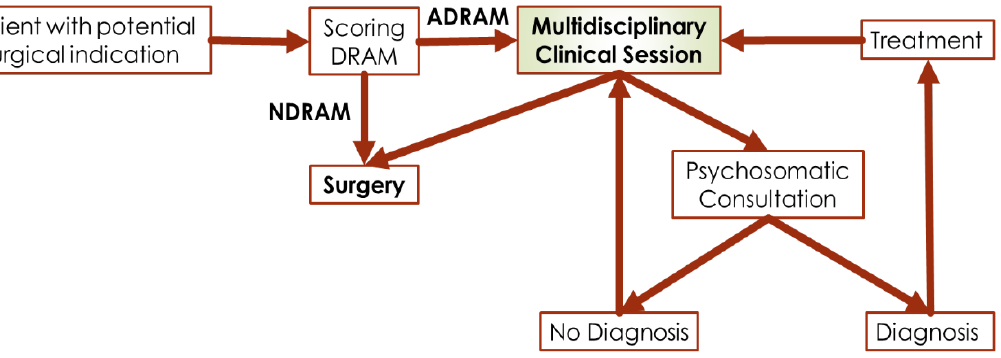
Figure 5. Structure of the multidisciplinary clinical management of low back pain in our setting. Author Contributions: Conceptualization, A.S.-G. and M.F.-G.; methodology, A.S.-G.; software, A.S.-G. and